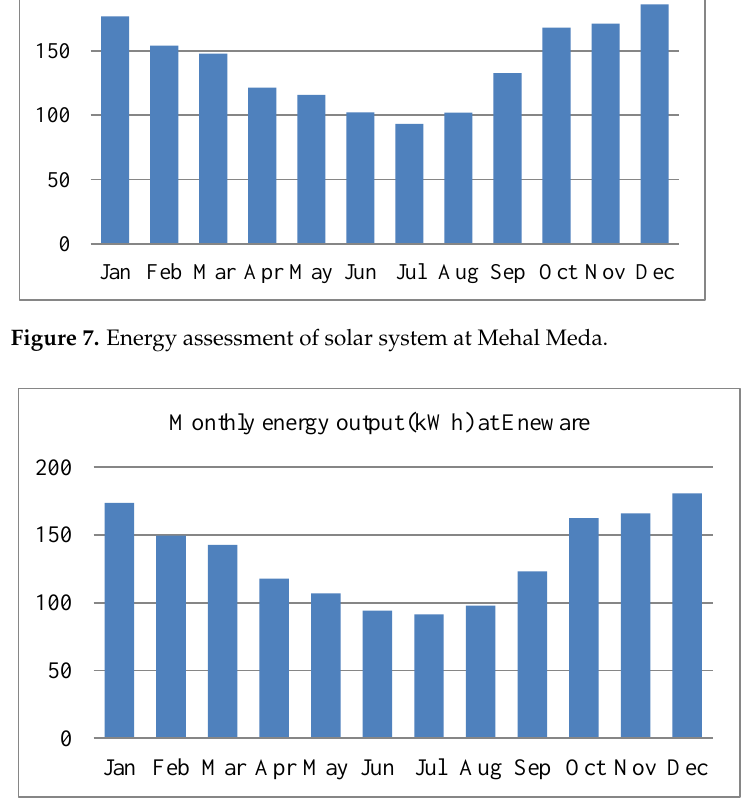
Figure 8. Energy assessment of solar system at Eneware.